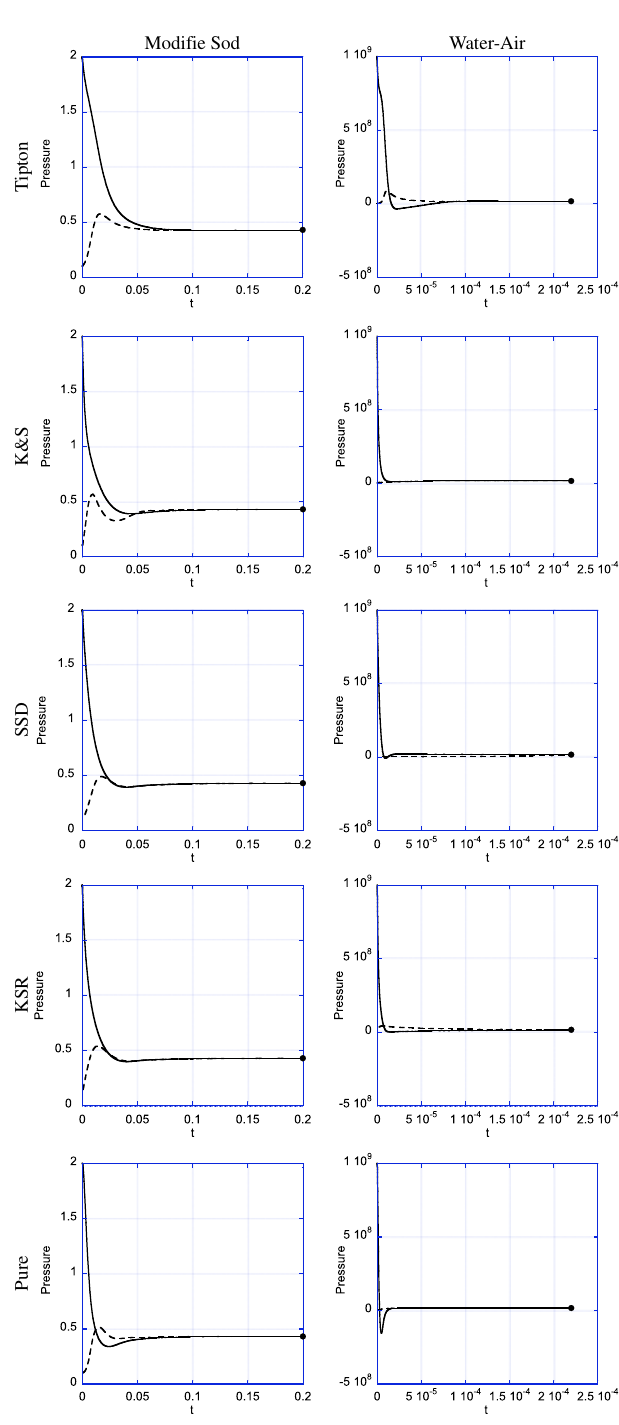
Fig. 1. Time-history plots for the pressure in the mixed cell for modified Sod shock tube problem (left column) and the water-air shock tube problem (right column) with Tipton’s method, K&S method, SSD method, the new KSR method and the pure-cell calculation. The top four rows are for two materials in the mixed cell; the bottom row is for the cells immediately adjacent to the material interface. The solid line indicates the left material (material 1), the dotted line represents the right material (material 2), and the bullets represent the exact solution at the final